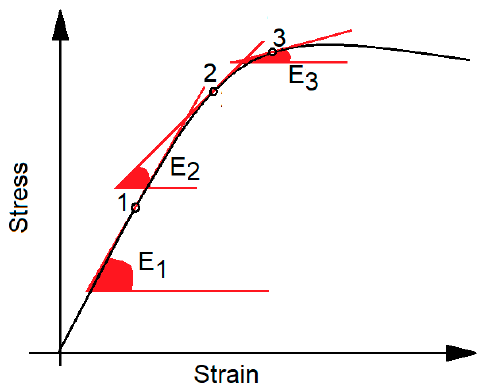
Figure 5. Nonlinear stress/strain curve: working at different strain (red dots ‘ 1’ , ‘ 2’ , ‘ 3’ ) implies working with different elastic moduli E 1 , E 2 , E 3 that are the slope of the respective tangent lines.